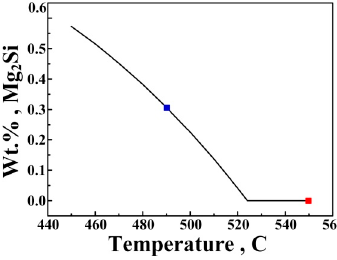
Figure 3. Vickers Hardness of ( a ) water quenching (WQ); ( b ) CR; ( c ) RQ of Al 6061 alloy aged at 180 °C as a function of ageing time.